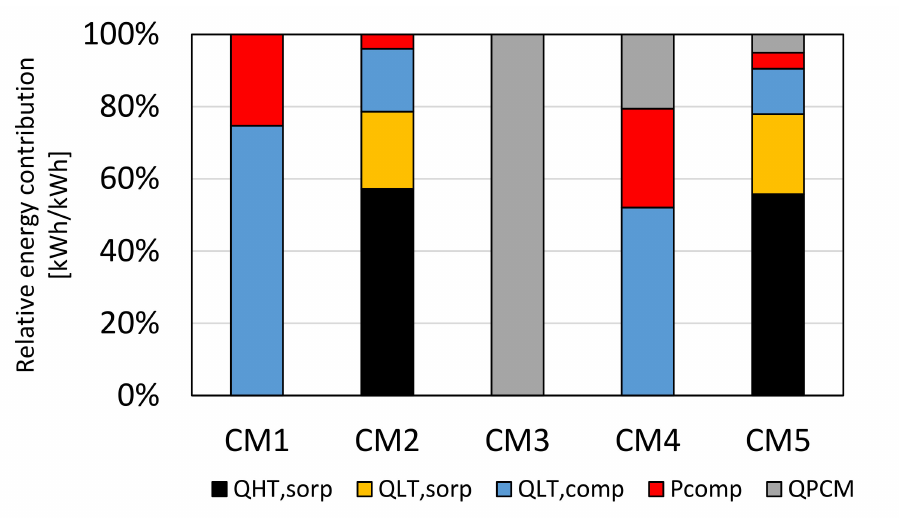
Figure 11. Relative energy contributions to the overall energy inputs of HYBUILD system for different Cooling Modes (CMs).